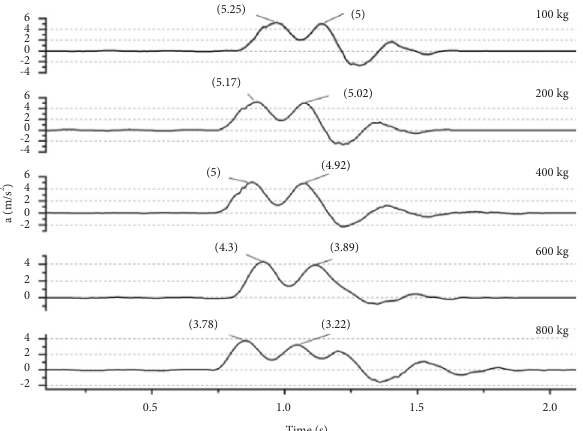
Figure 11: Longitudinal vibrations of the car during the downward emergency stop.